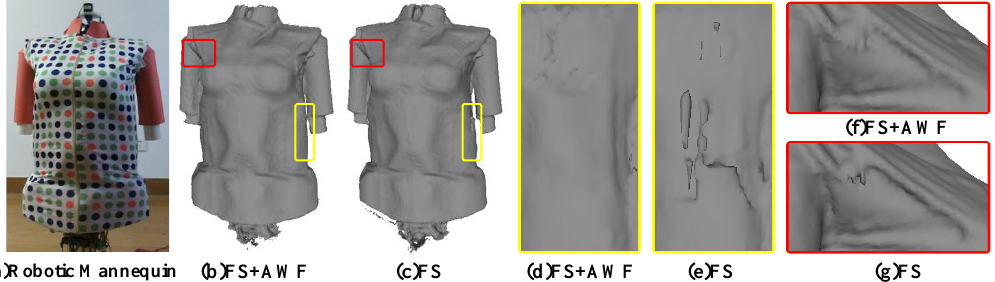
Figure 12. The validation of the depth adaptive weight field, ( a ) is the used robotic mannequin and customized clothing; ( b , d , f ) are the results obtained by using the new fusion strategy (FS) and the adaptive weight field (AWF); ( c , e , g ) are the results obtained only by using the new fusion strategy(FS).